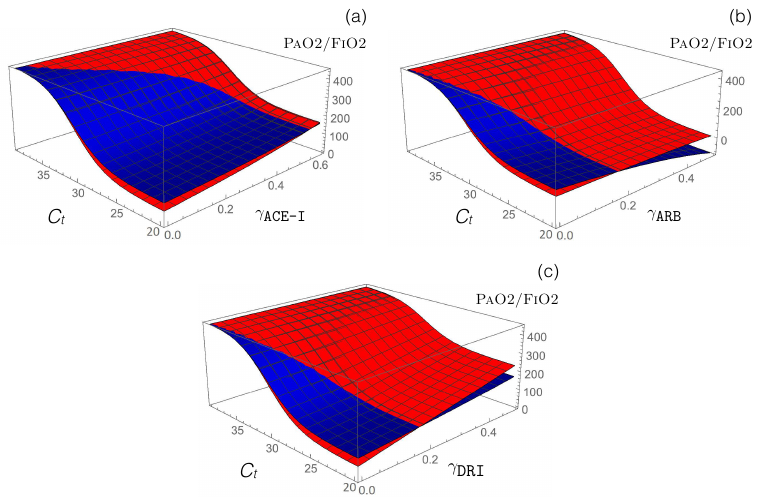
Figure 4. Impact of different RAS-blocking drugs in normotensive (blue) and hypertensive (red) SARS-CoV-2 patients. Predicted P A O2/F I O2 value as a function of the cycle threshold value C t and